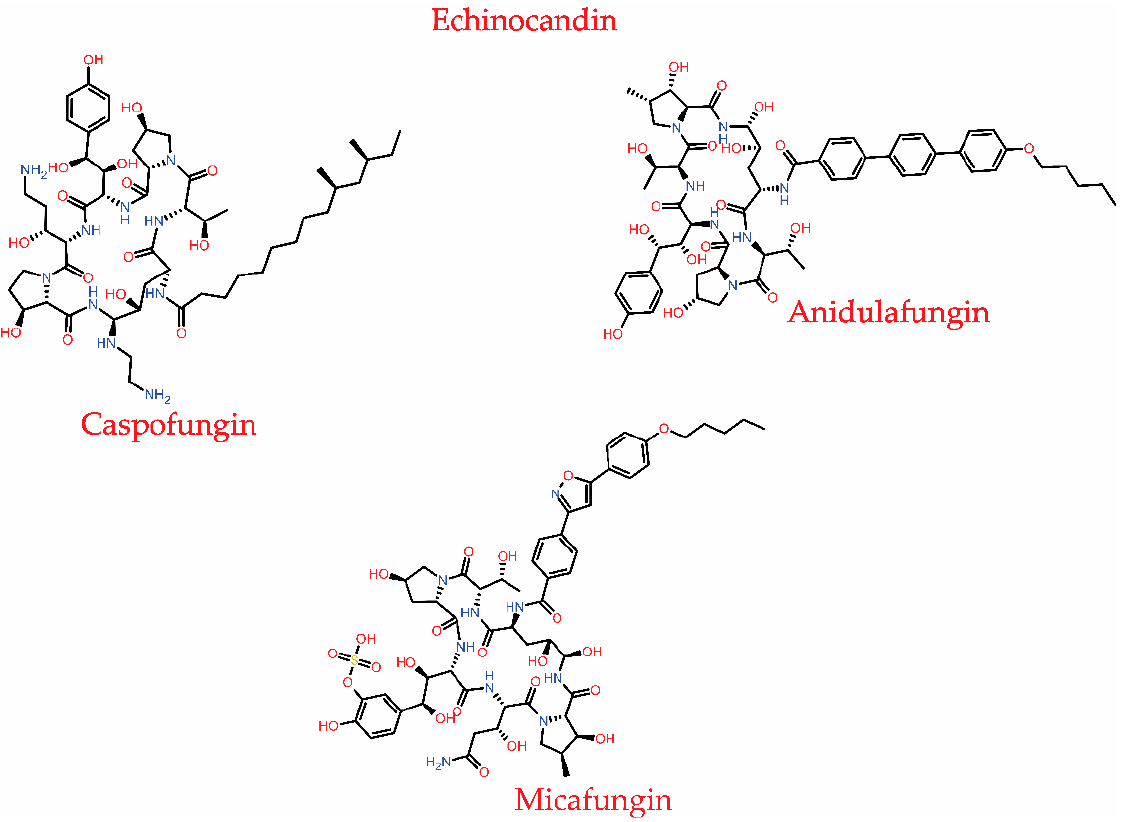
Figure 8. Two-dimensional structure of drugs under the echinocandin antifungal group .